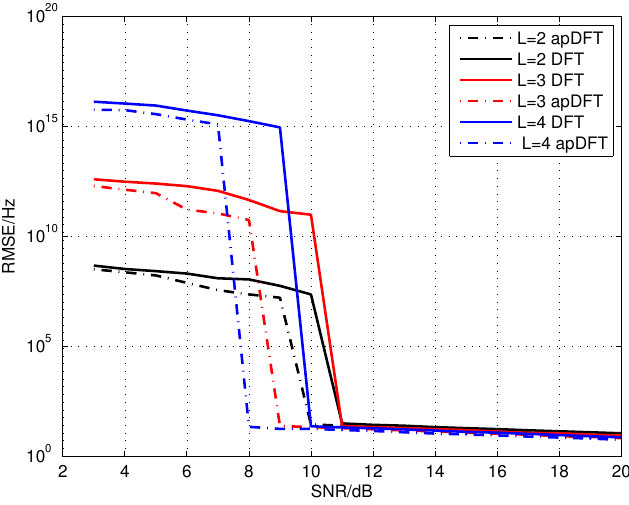
Figure 8. RMSE results of frequency estimation under different number of data acquisition